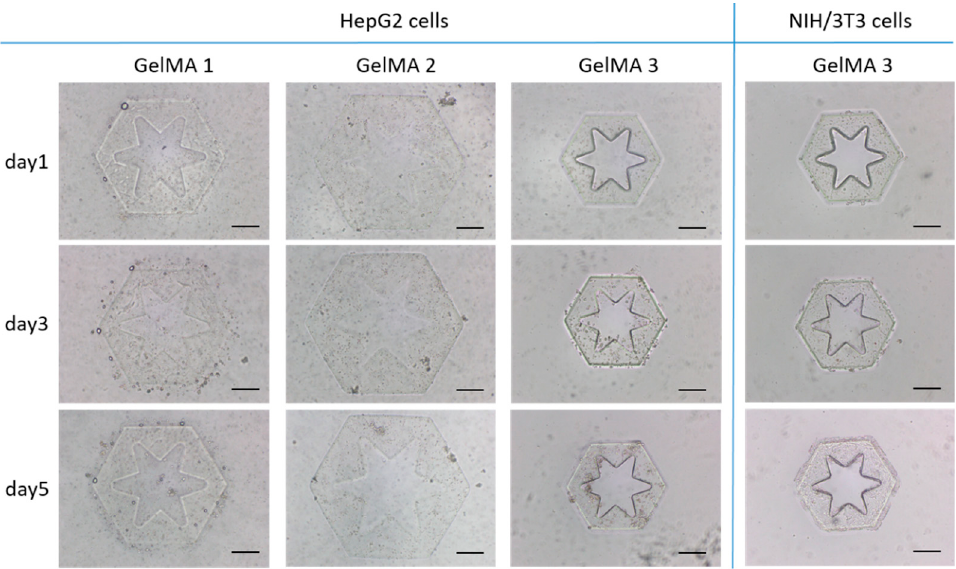
Figure 1. HepG2 cells and NIH/3T3 cells growth in micromodules fabricated by different kinds of GelMA. Scale bar: 200 μ m.